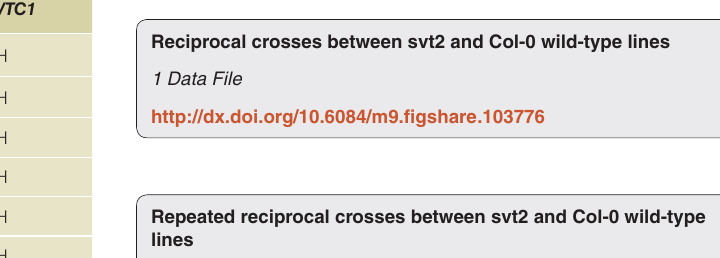
Table 5. Reciprocal crosses between svt2 and Col-0 wild-type lines. Molecular analysis of the InDel polymorphism markers showed evidence of cryptic but persistent homozygosity, irrespective of the direction of the sexual cross (highlighted in red). However, heterozygosity was expected at all loci. Female × Male